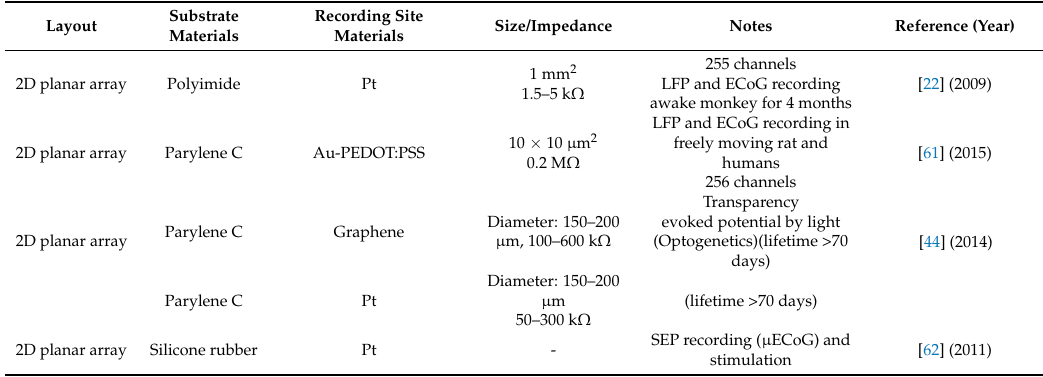
Table 1. Comparison of different electrocorticography (ECoG) and micro-ECoG ( µ ECoG) electrodes with regards to various